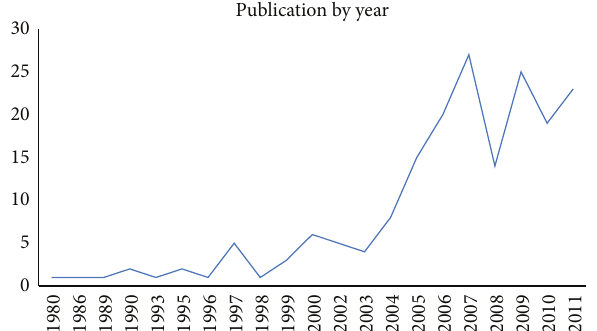
Figure 1: Graph clearly indicates an increasing trend on research work conducted on keystroke dynamics